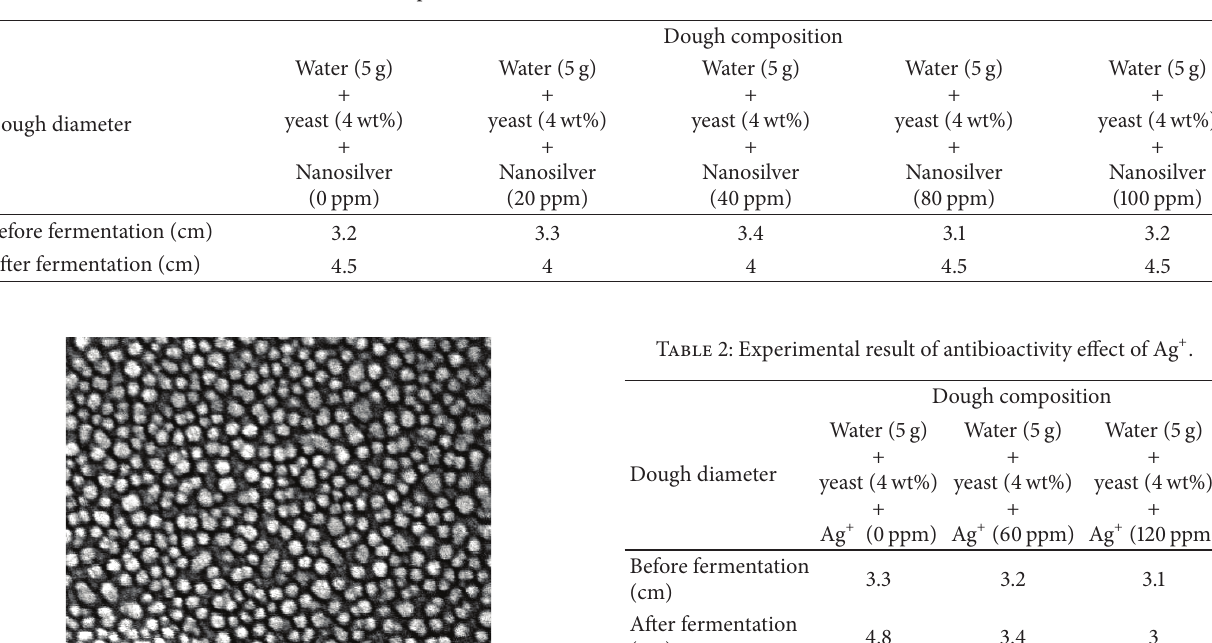
Table 1: Experimental result of antibioactive effect of nanosilver.